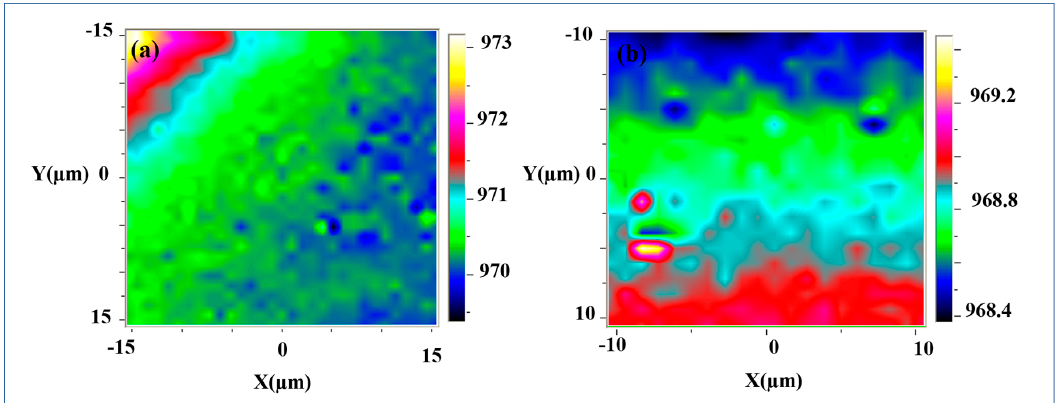
Figure 11. A 1 (LO) modes Raman shift position in the different areas [126]. ( a )—single graphene layer A 1 A 1 (LO) mode position demonstrates blue-ward shift by approximately 4cm − 1 ; ( b )—bilayer graphene A 2 —A 1 (LO) mode position demonstrates blue-ward shift by approximately 1cm − 1 Similar dependencies of the A 1 (LO) mode are observed in graphite A 3 .